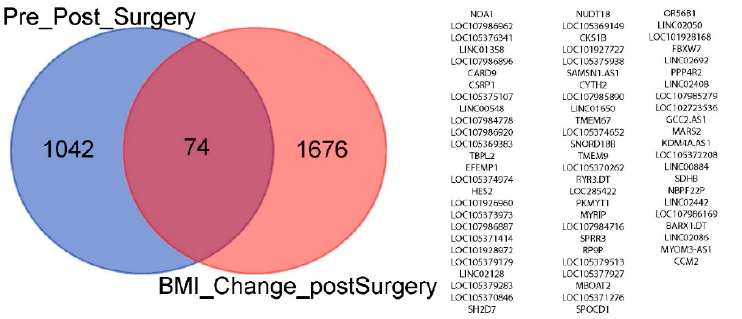
Figure 3. Comparison of genes changing in the post-RYGB samples with respect to the change in BMI (Table S2) vs. genes identified between the pre- vs. post-RYGB genes (Table